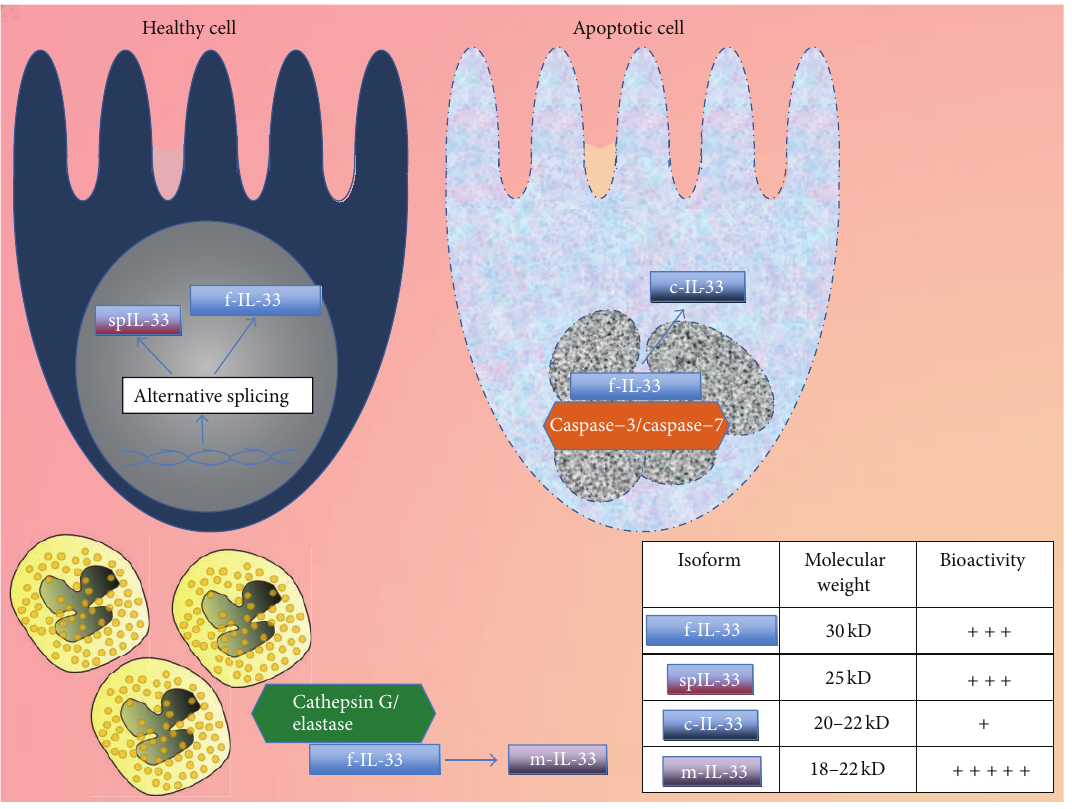
Figure 1: IL-33 isoforms and their associated bioactivity. IL-33 is synthesized as a 30kD protein (full-length-IL-33, f-IL-33); however, alternative splicing can generate a 25 kD peptide (splice-IL-33, spIL-33), which possesses similar bioactivity to f-IL-33, but lacks caspase cleavagesites.Duringcellularapoptosis,f-IL-33servesasapotentialsubstrateforpro-apoptoticcaspases(caspase-3andcaspase-7),generating smaller peptides of 20–22 kD with a marked reduction in bioactivity. Conversely, when secreted extracellularly, the proinflammatory activity of f-IL-33 may be potentiated in the context of a permissive, proinflammatory environment. In fact, Cathepsin G and elastase, released extracellularly by degranulating neutrophils, are able to cleave f-IL-33 into smaller isoforms (mature-IL-33, m-IL-33, 18–22 kD), which have been reported to display the greatest